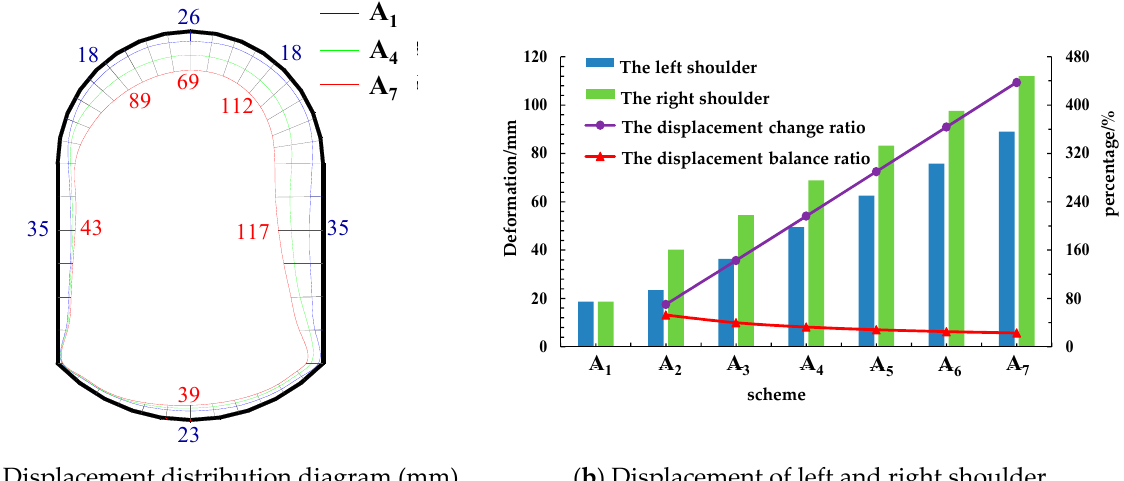
Figure 6. Displacement analysis of different asymmetric coefficients. ( a ) Displacement distribution diagram ( b ) Displace- ment of left and right shoulder.